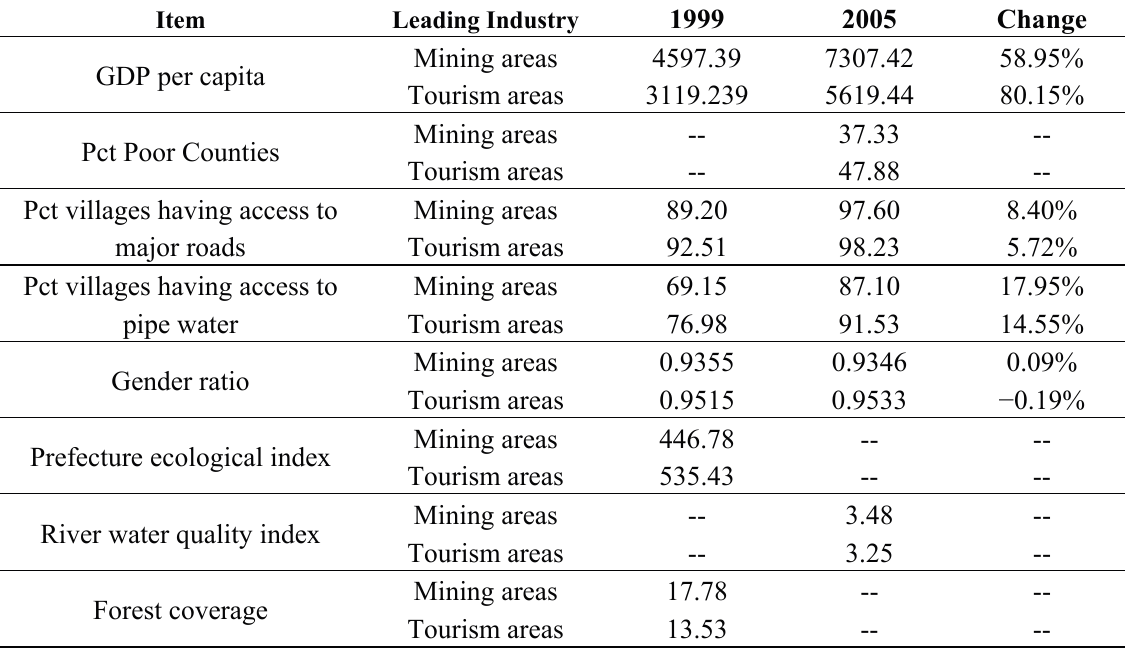
Table 2. Comparing mining areas and tourism